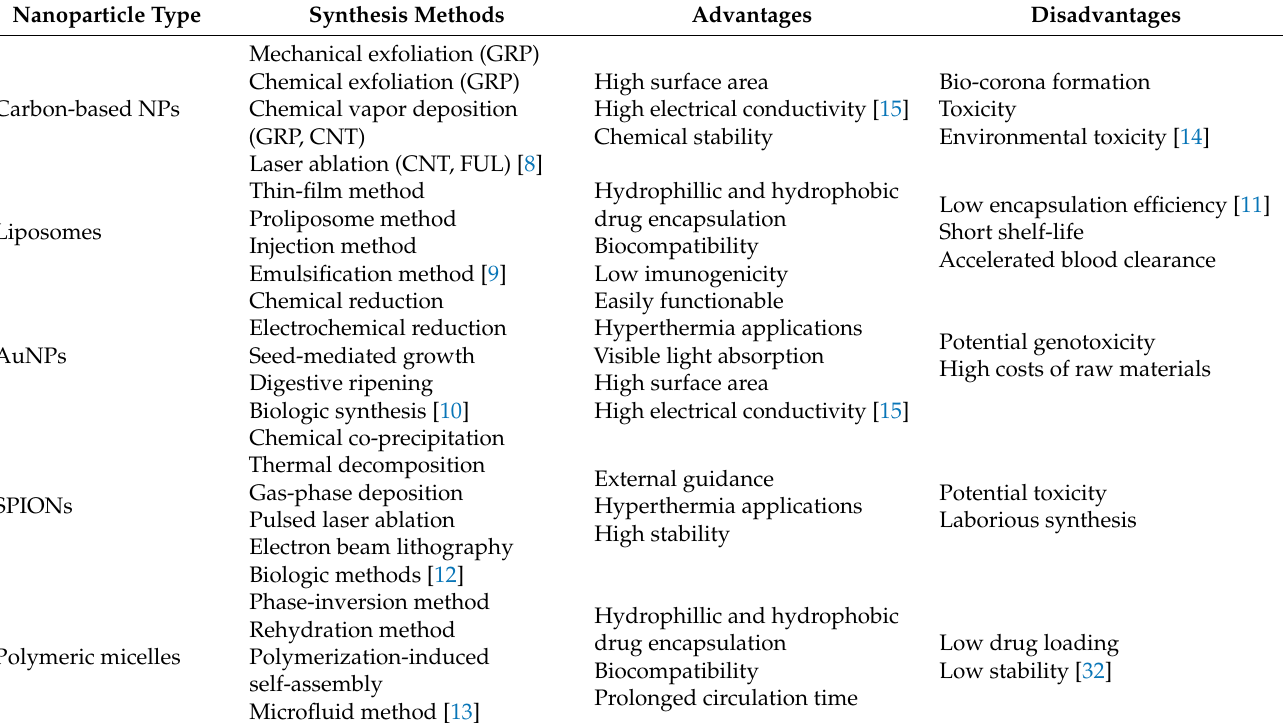
Table 1. Synthesis methods, advantages, and disadvantages of different types of